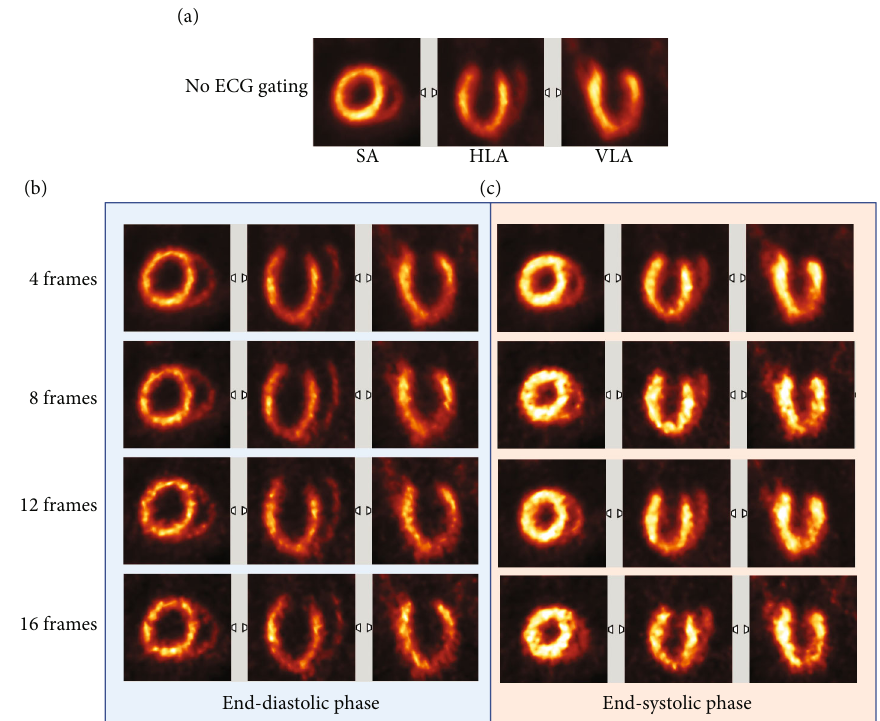
Figure 2: 18 F-FDG PET images of a rat heart with no ECG-gated reconstruction (a) and with di ff erent ECG-gated frame numbers at end- diastolic (b) and end-systolic phases (c). SA: short axis; HLA: horizontal long axis; VLA: vertical long